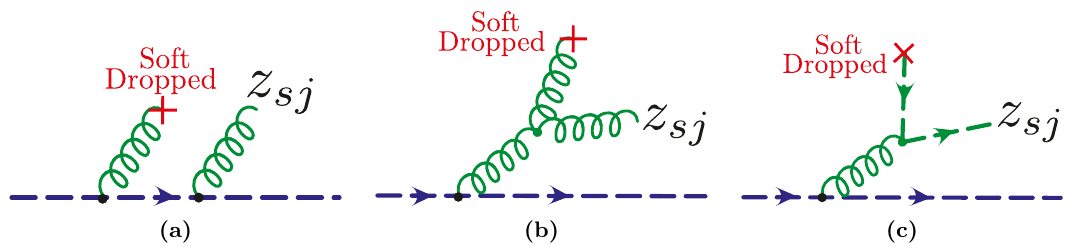
Figure 9. Structure of emissions at one-loop order that contribute to the hard matching function in the soft subjet factorization formula for groomed jets. The emission at a wider angle will be groomed away, while the other emission sets the mass of the jet. (a) corresponds to the Abelian emission of gluons, and will contribute proportional to C F ; (b) corresponds to non-Abelian gluon emissions, and will contribute proportional to C A ; and (c) corresponds to a gluon splitting to quarks, which contributes proportional to n F